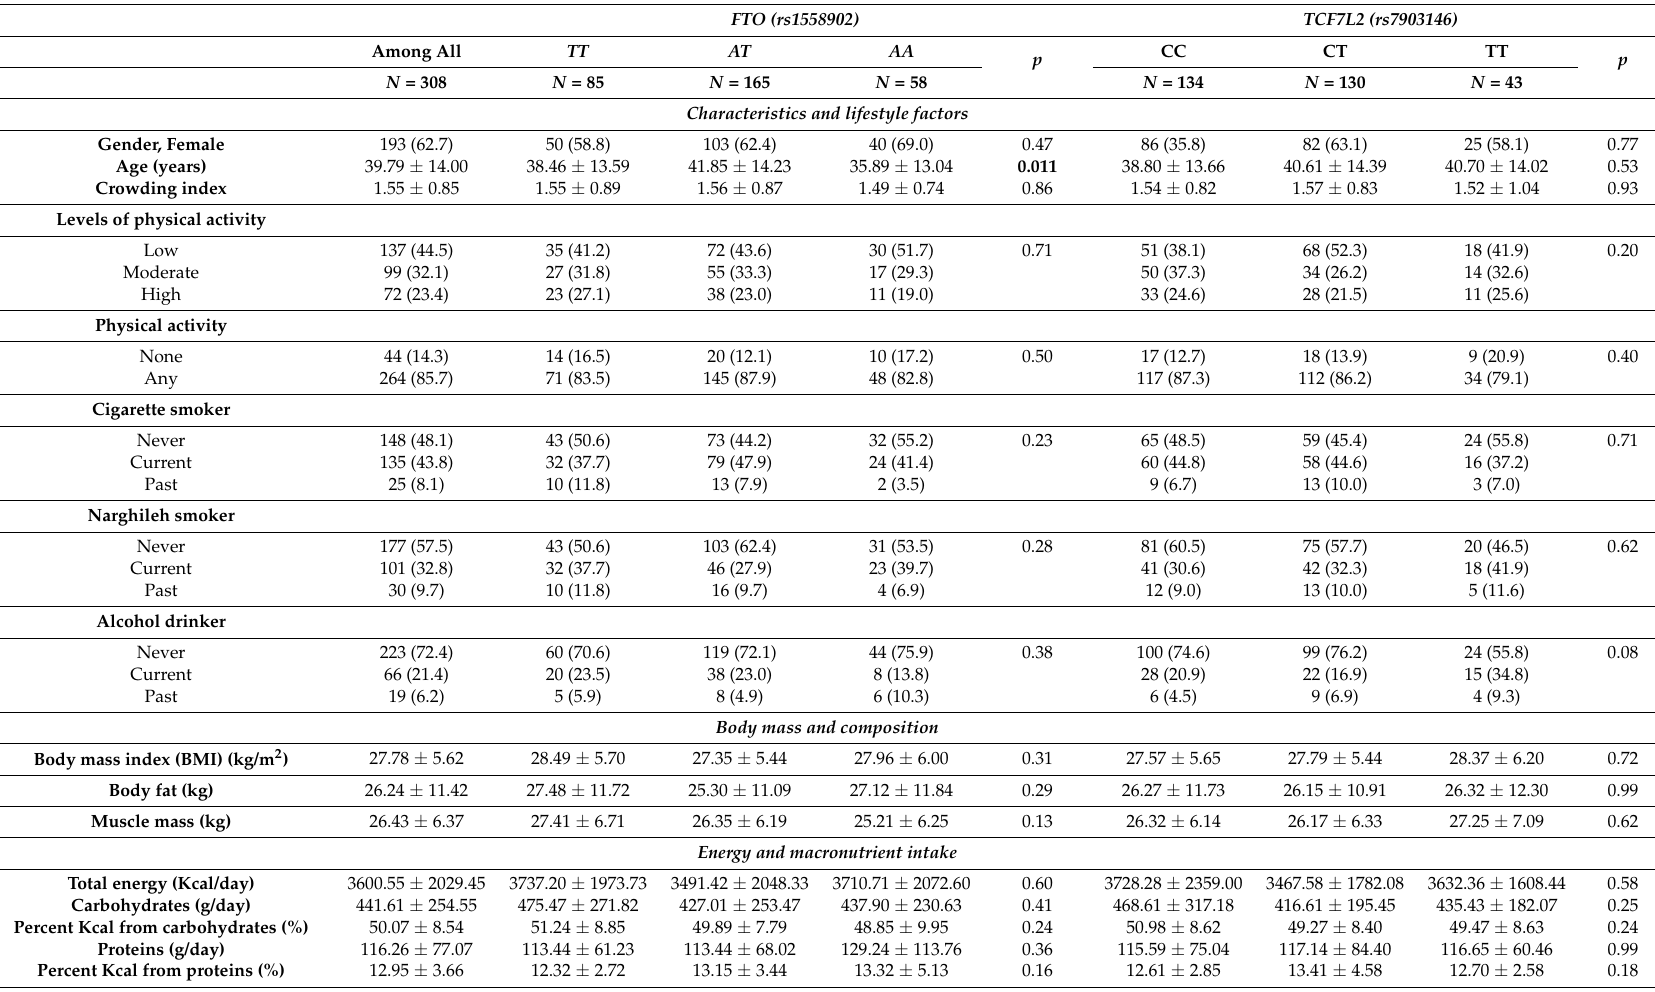
Table 1. Associations of baseline characteristics, lifestyle, and dietary habits for those with FTO (rs9939609) and TCF7L2 (rs7903146) genotypes. FTO (rs1558902) TCF7L2 (rs7903146) Among All TT AT AA p CC CT TT p N = 308 N = 85 N = 165 N = 58 N = 134 N = 130 N = 43 Characteristics and lifestyle factors Gender, Female 193 (62.7)